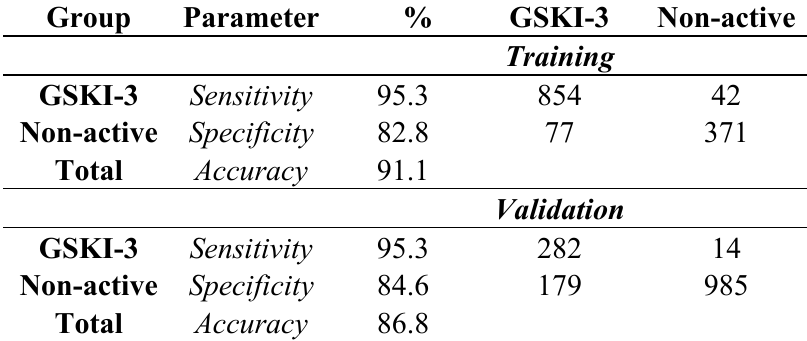
Table 2. Training and validation